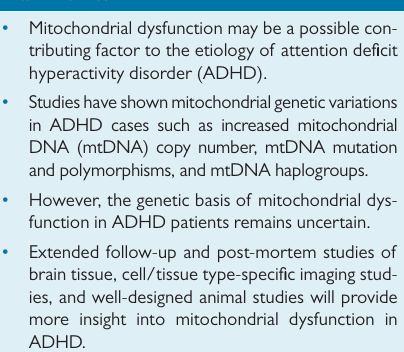
Figure 1. Summary of diagnostic approaches to mitochondrial dysfunction. Adapted from Hubens et al.